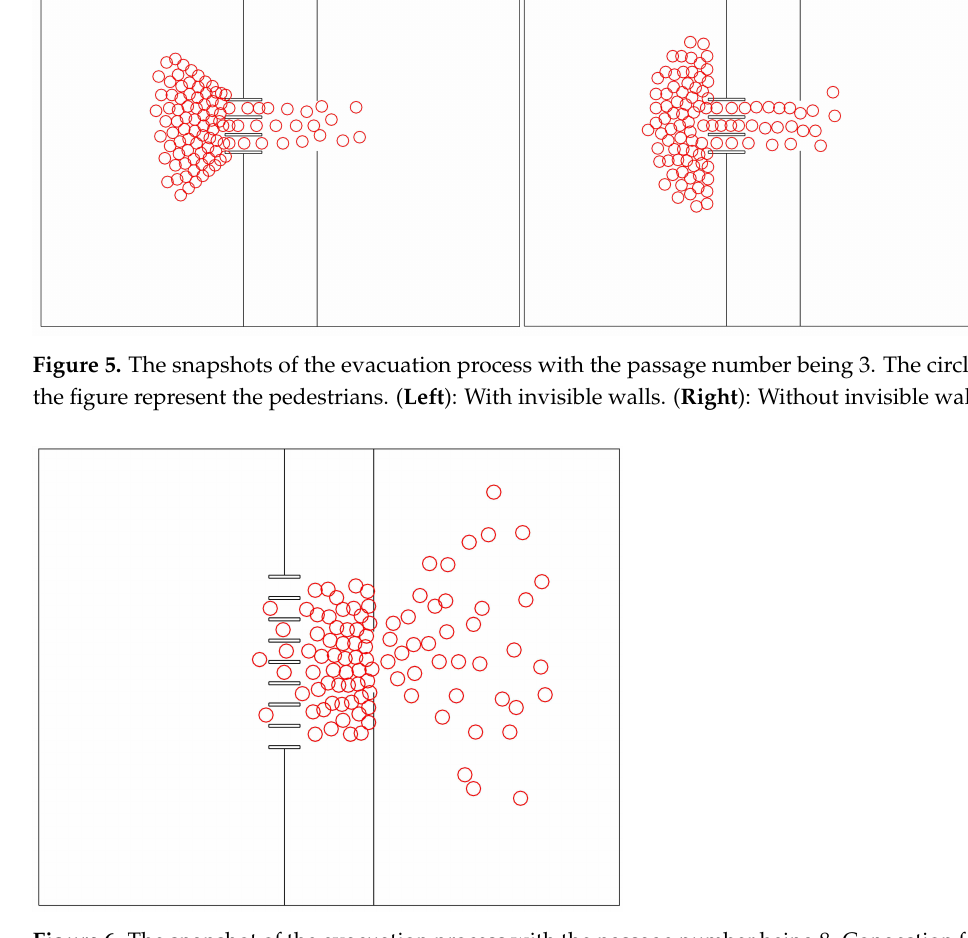
Figure 6. The snapshot of the evacuation process with the passage number being 8. Congestion forms at the exit.